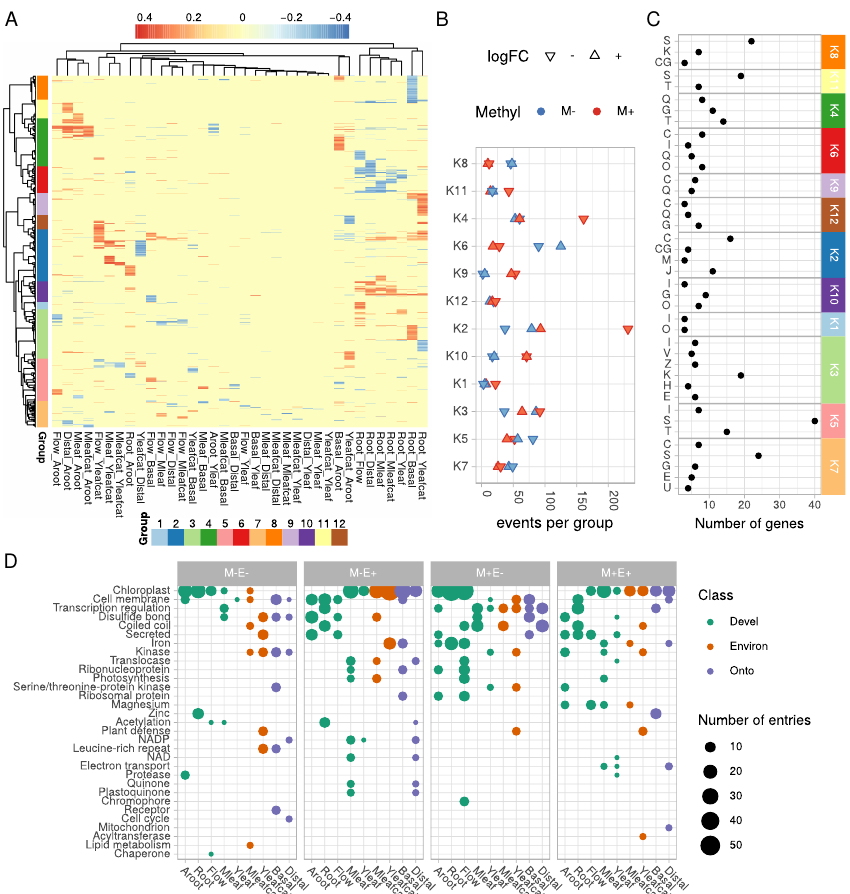
Figure 4. Characterization of differentially expressed and methylated (DEM) genes . ( A ) heatmap of DNA methylation differences for each differentially expressed and methylated gene model and each comparison. Cell color is proportional to the methylation difference (blue to red scale). Comparisons and gene loci are clustered according to the Euclidean distance and the Ward’s aggregation criterion. ( B ) for each group in ( A ) DEM events (one gene in one comparison) were counted for each trend (over/under expressed (logFC) and hypo/hyper methylated (Methyl)). ( C ) EggNOG functional annotation of gene clusters from the heatmap in A. Only enriched classes are shown (hypergeometric test, Bonferroni ajdusted- p -value < 0.05). A, RNA processing and modification; B, Chromatin structure and dynamics; C, Energy production and conversion; D, Cell cycle control, cell division, chromosome partitioning; E, Amino acid transport and metabolism; F, Nucleotide transport and metabolism; G, Carbohydrate transport and metabolism; H, Coenzyme transport and metabolism; I, Lipid transport and metabolism; J, Translation, ribosomal structure and biogenesis; K, Transcription; L, Replication, recombination and repair; M, Cell wall/membrane/envelope biogenesis; N, Cell motility; O, Post-translational modification, protein turnover, and chaperones; P, Inorganic ion transport and metabolism; Q, Secondary metabolites biosynthesis, transport, and catabolism; R, General function prediction only; S, Function unknown; T, Signal transduction mechanisms; U, Intracellular trafficking, secretion, and vesicular transport; V, Defense mechanisms; W, Extracellular structures; Y, Nuclear structure; Z, Cytoskeleton. ( D ) most represented Uniprot keywords for DEM genes in for each sample and methylation/expression profile. For each sample, all nine comparisons were made to identify gene sets following one the four profiles: M-E-, hypomethylated and decreased expression; M-E+, hypomethylated and overexpressed; M+E-, hypermethylated and decreased expression; M+E+, hypermethylated and overexpressed. Each corresponding Uniprot entry was mapped to Uniprot keywords, which were then summarized for each